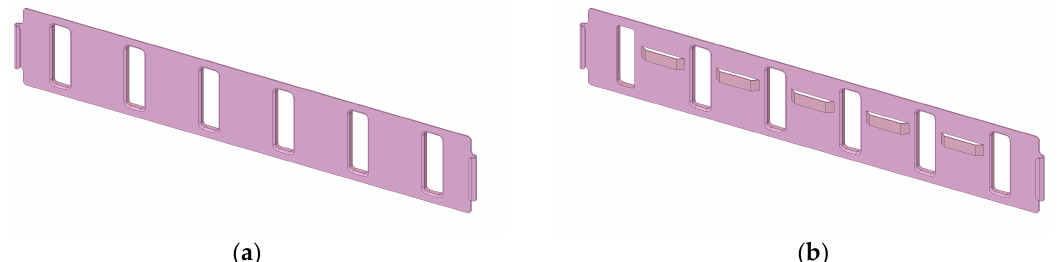
Figure 2. Radiation fin designs: ( a ) Plate fin; ( b ) modified louver fin.